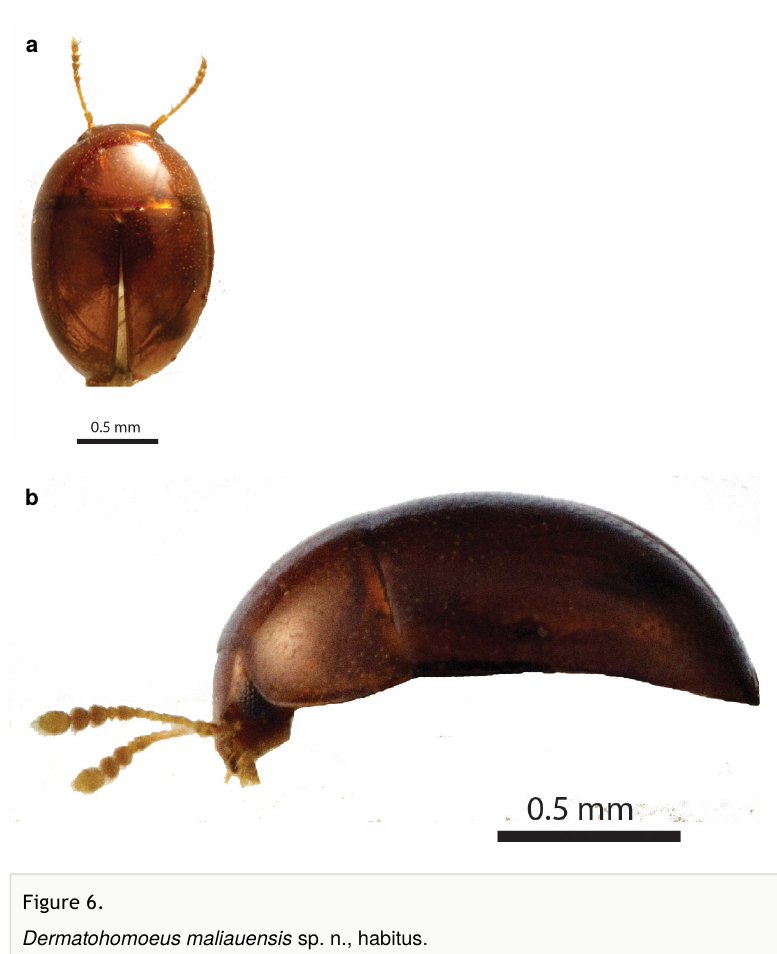
Pronotum : Broadest at the base. Pronotal posterior angle rounded, not drawn out, the pronotal basis near the posterior angle with only a very faint convex curve. Pronotum smooth, glossy, hairless, without any microreticulation but with very fi ne and sparse punctuation, punctures spaced at 3-5 times their diameter, nearly invisible at 50x magni fi cation (Fig. 7b). A fi ne, continuous margin runs along the lateral and anterior margin. Scutellum : Microsculptured as on pronotum.